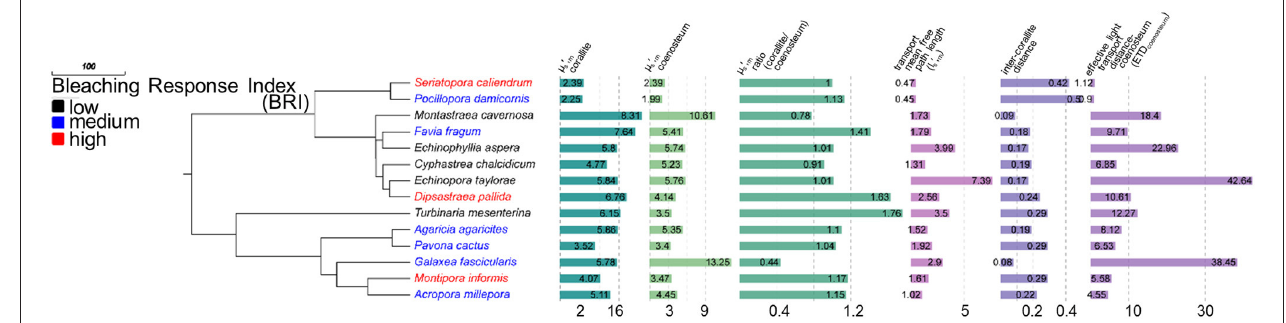
FIGURE 2 | Coral phylogeny of 14 species modified from Huang (2012) with isolated skeletal scattering ( µ s , m ′ ) values for corallites and coenosteum. Coral species color coded by bleaching response and bar graphs represent variation in skeletal characters. Higher corallite µ s , m ′ values, relative to coenosteum, are associated with increased bleaching response (PCC 0.69, p 0.006). Lower coenostem effective transport distances (ETD coenosteum ) are associated with increased bleaching = = response (PCC 0.603, p 0.022, n = − = =